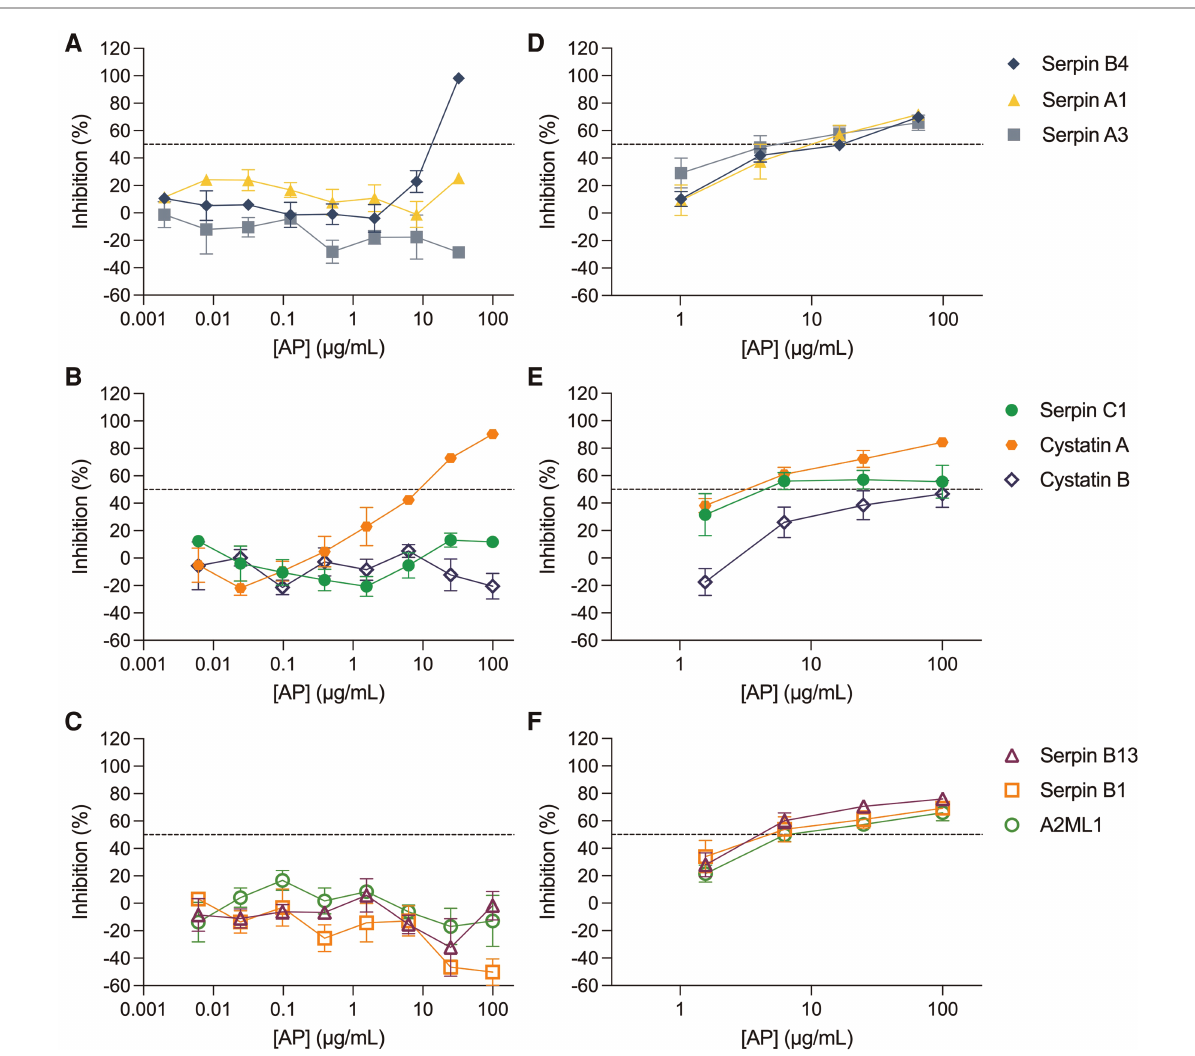
FIGURE 1 Activity of antiproteases in cellular and tissue explant models. Antiproteases (APs) were titrated against HIV-1 BaL in TZM-bl cells ( A – C ) and ecto- cervical explants ( D – F ). The percentage of inhibition by each AP was normalized relative to the r.l.u values obtained for cells or p24 values obtained for explants not exposed to virus (0% infectivity) and for cells or explants infected with virus in the absence of AP (100% infectivity). Data are means (± SEM) from at least two independent experiments performed in triplicate. Dashed line in each panel represents 50% of